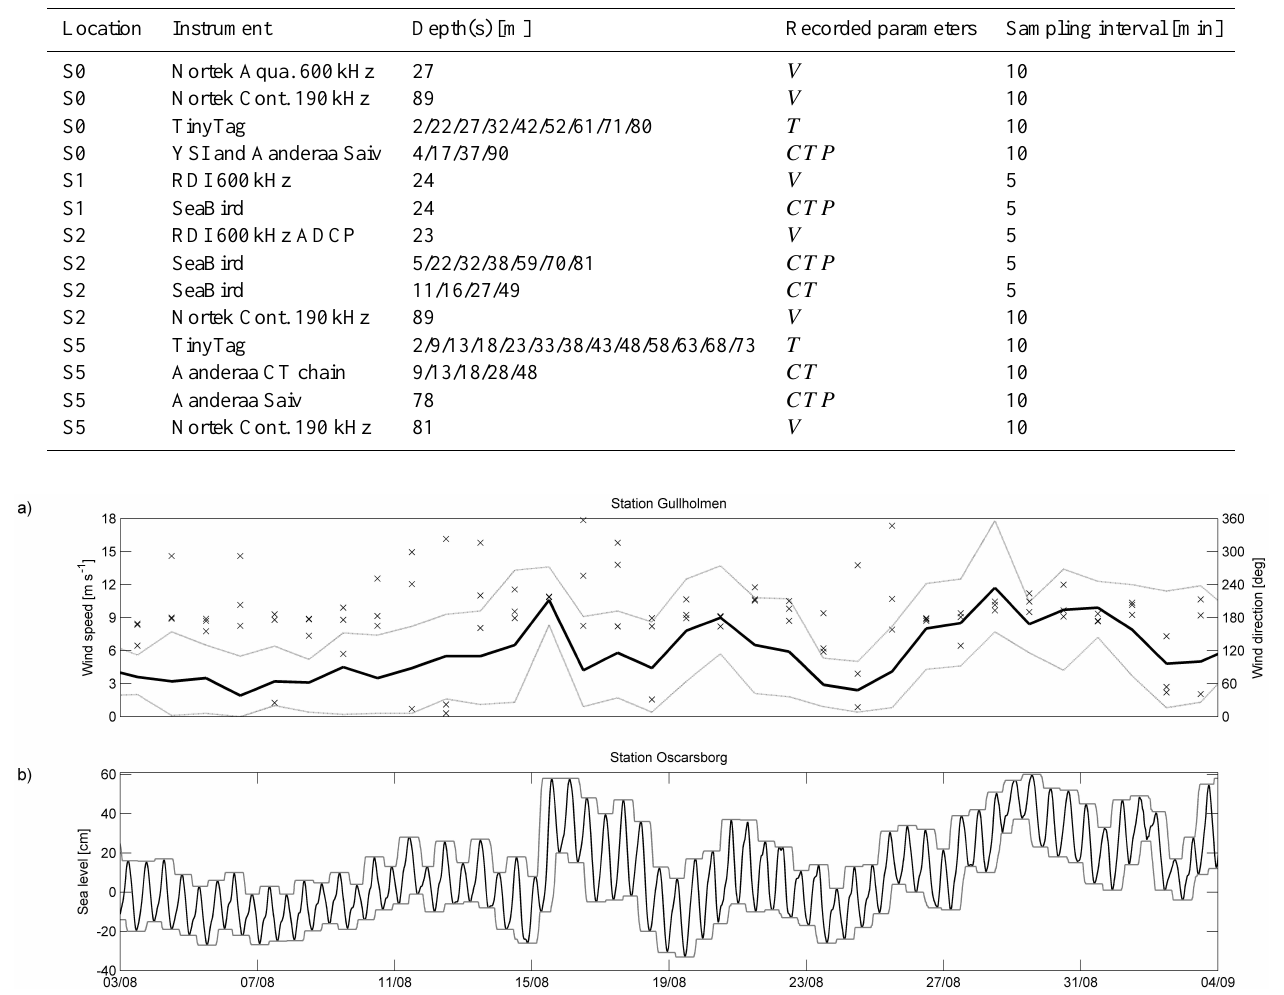
depth, extending from the northern tip of Nesodden to the mainland on the other side, separate the two basins (Fig.